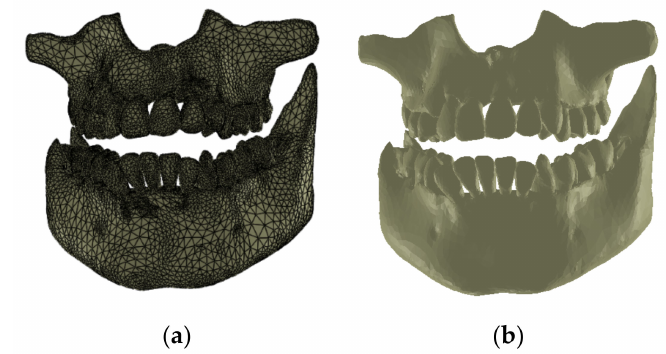
Figure 11. Complete structure—two viewing modes ( a , b